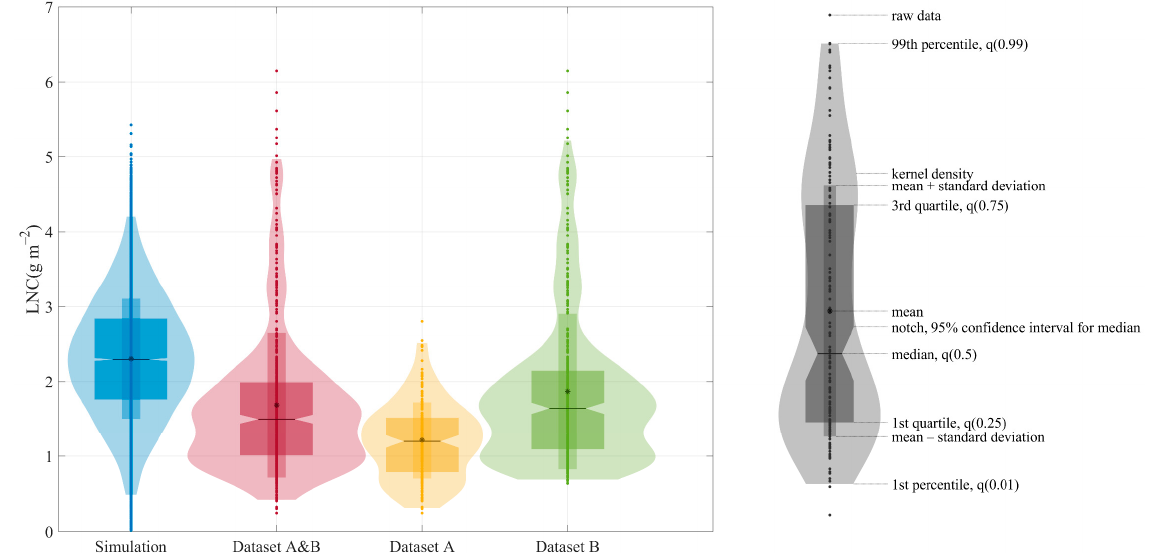
Figure 1. Properties of LNC in different datasets. Dataset A&B is a composite of all field-measured leaf samples in both dataset A and dataset B. The statistical meanings in the diagram are illustrated in the left panel.